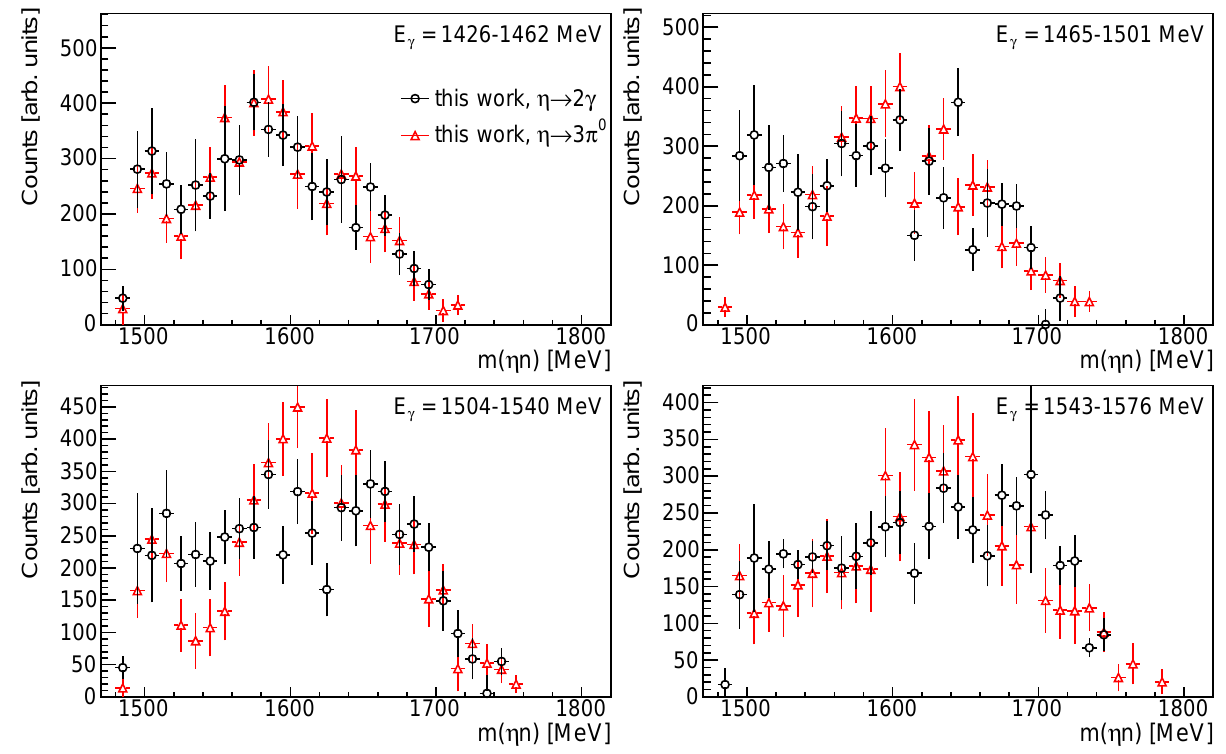
Figure 6. Invariant mass m ( η n ) of γ p → ηπ + n for four bins of photon-beam energy (no acceptance correction). Two data samples using the η → 2 γ decay (black circles) and the η → 3 π 0 decay (red triangles, normalized by integral ratio) have been